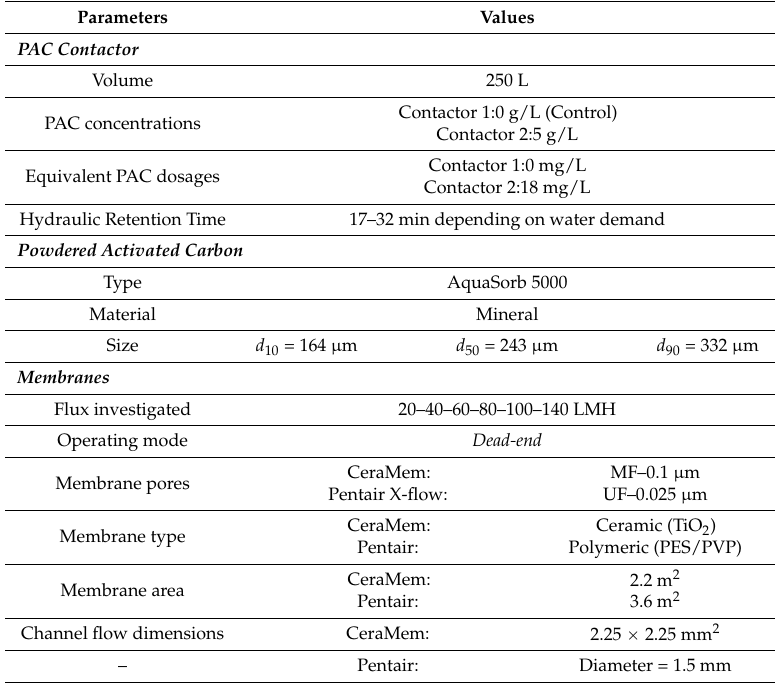
Table 2. Hybrid Membrane Process (HMP) design parameters and operating conditions.